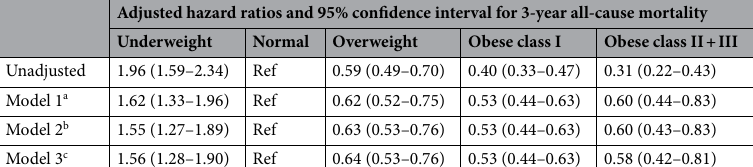
Adjusted hazard ratios and 95% confidence interval for 3-year all-cause mortality Underweight Normal Overweight Obese class I Obese class II +